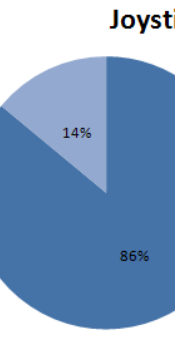
Fig. 23. Success rate in the medical procedure with a Joystick.